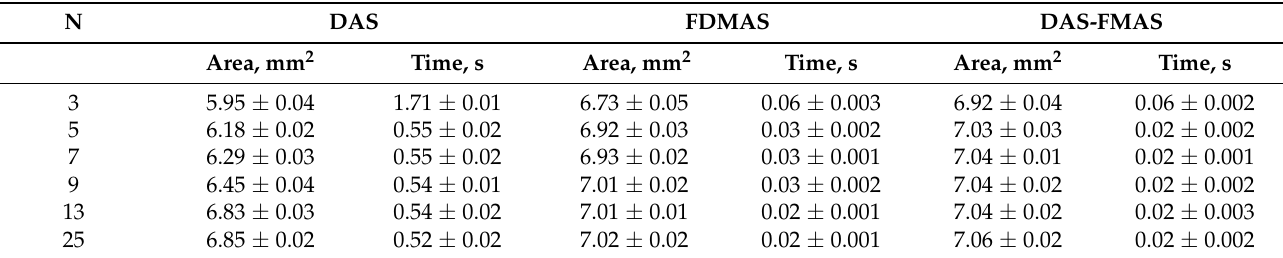
Table 3. Segmented region size and snake convergence time for 100 iterations.